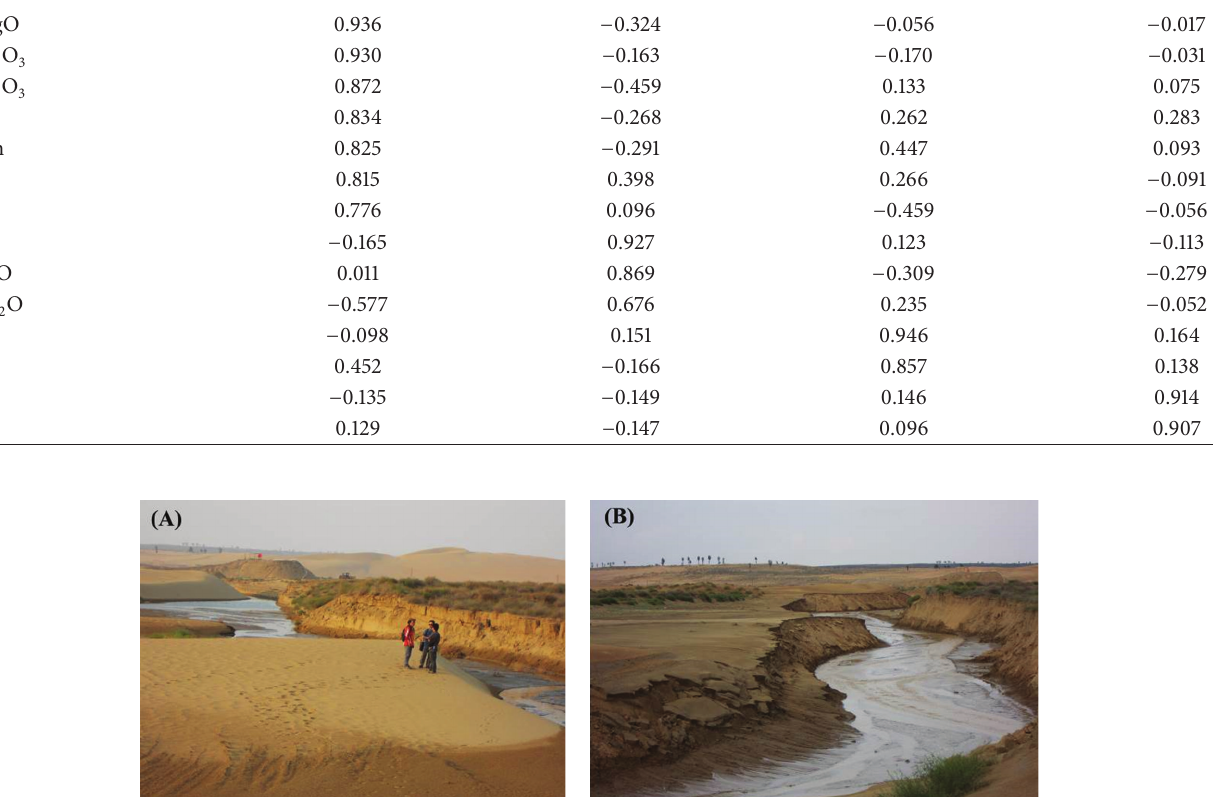
Figure 11: Graphic evidence of aeolian sand storage loss and lateral enlargement of the desert channel after the flood on August 23, 2011. (A) Preflood channel section in May 2011; (B) postflood channel section on August 26,